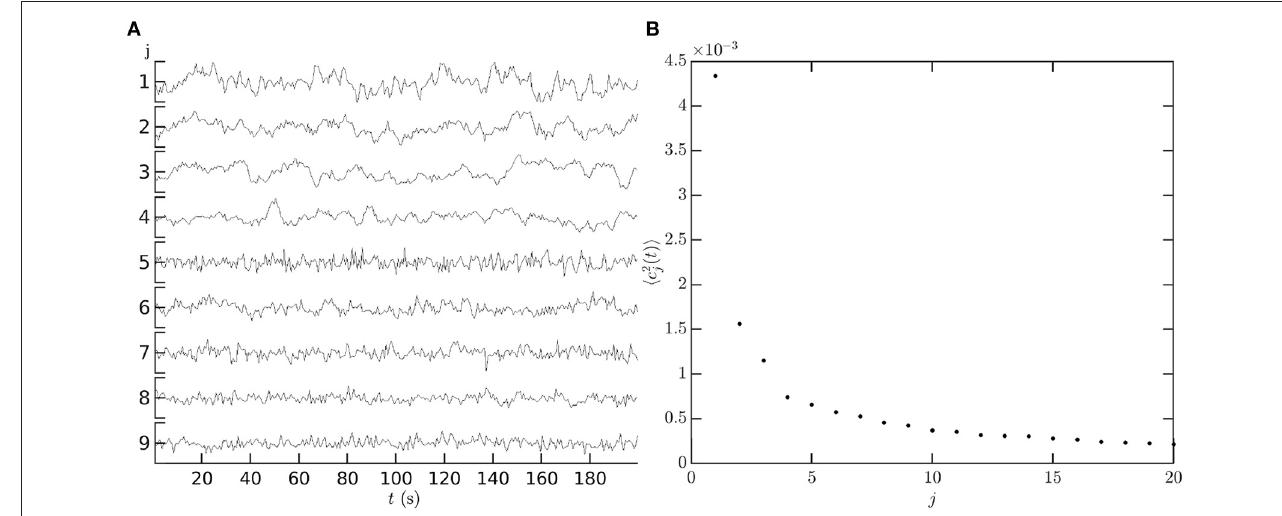
FIGURE 12 | Temporal dependence of mode coefficients. (A) c j ( t ), for the first nine covariance modes from a single resting state fMRI scan in the HCP1200 dataset ( Glasser et al., 2013). For each mode j vertical axis tick marks are at